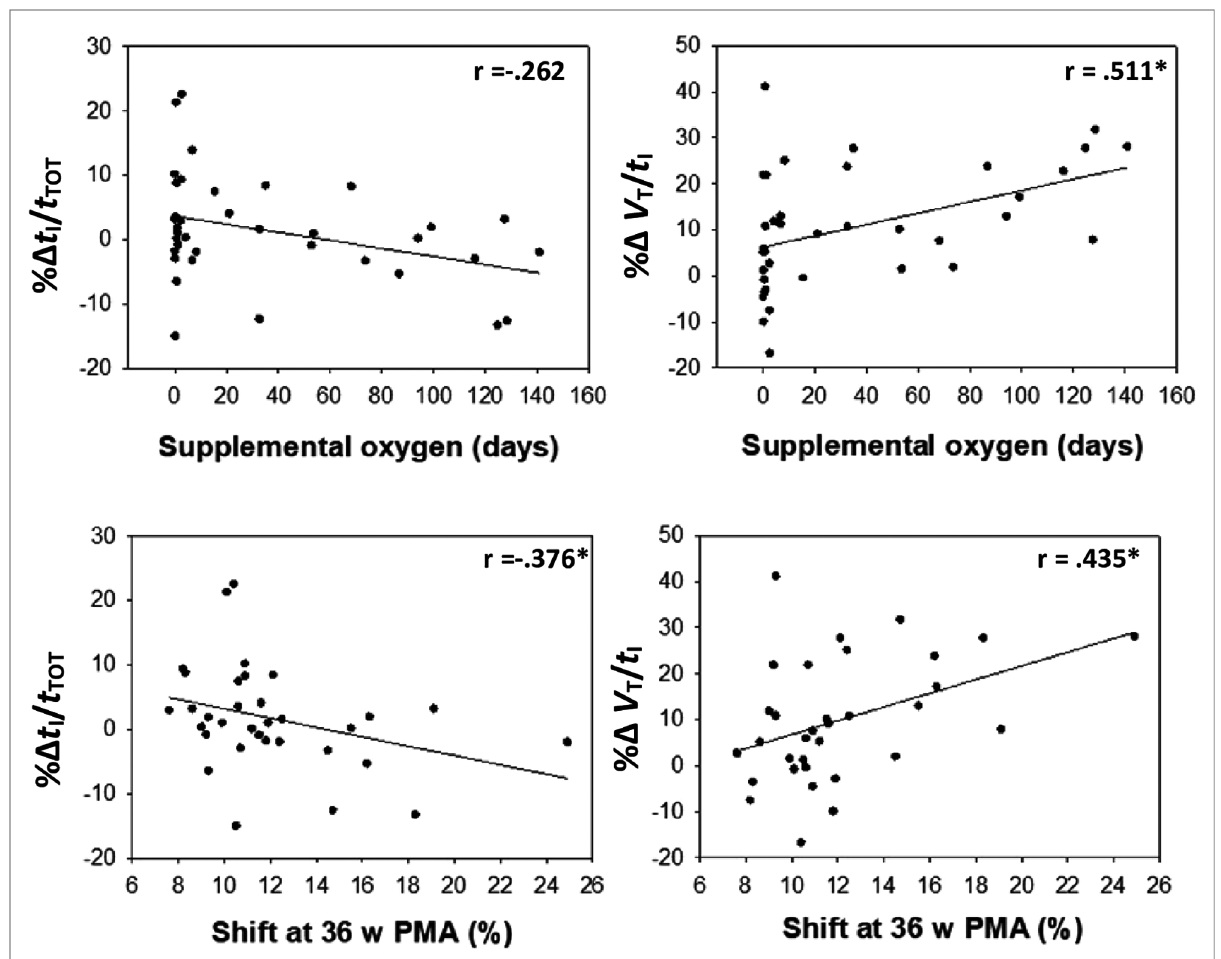
FIGURE 5 Change (% from baseline) in the driving ( V T / t I ) and timing ( t I / t TOT ) components of the breathing cycle during hypoxia are correlated with days of supplemental oxygen and shift at 36 weeks ’